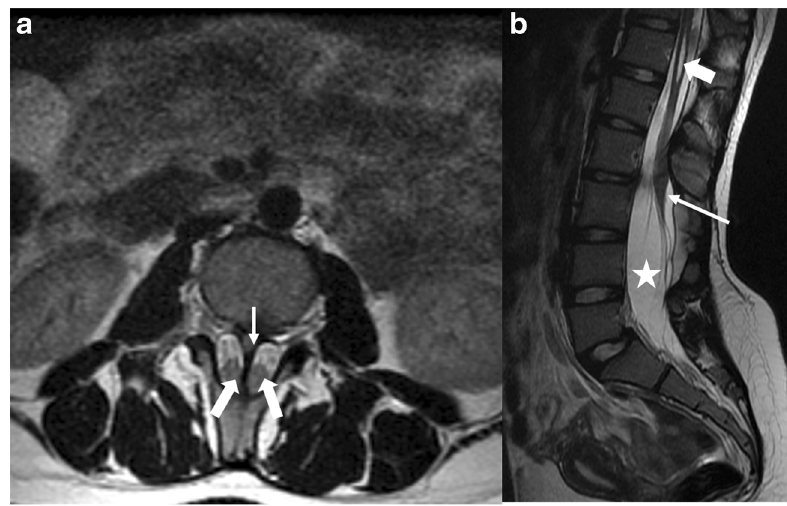
Fig. 4 a - b : Caudal/sacral agene- sis: Lateral radiograph of the spine ( a ) in one infant reveals ab- sence of the distal scacrococcygeal segments. Accompanying sagittal T2- weighted MR image ( b ) of the lumbar spine reveals abnormal truncation of the conus medullaris ( arrow ). c - e : Caudal agenesis (another neonate): Frontal radio- graph of the abdomen ( c ) in a ne- onate reveals absence of the entire lumbar and sacrococcygeal spine; the iliac bones are dysmorphic and abnormally close, though separate. Accompanying sagittal ( d ) and coronal ( e ) MR images of the spine reveal absence of the lumbar-sacrococcygeal segments of the spine. Abnormal high ter- mination and truncation of the spinal cord is noted ( arrow on d )